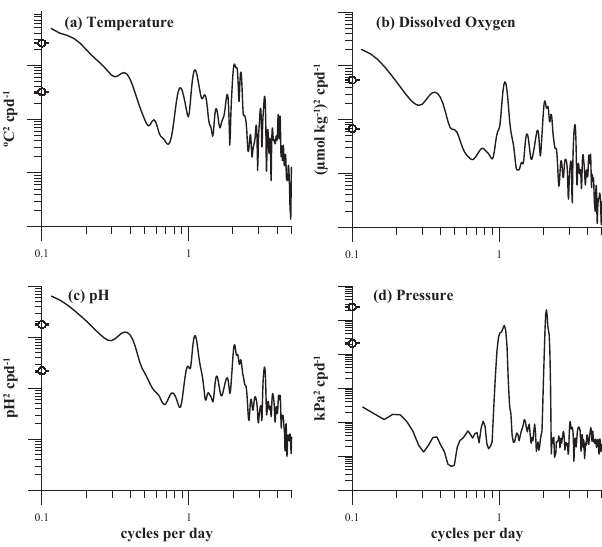
Fig. 2. Frequency power spectra (cycles per day) from mooring A at 7m water depth for (a) temperature, (b) dissolved oxygen, (c) pH and (d) pressure. The circles on the left side of each graph denote the critical scale for 95% confidence in energy